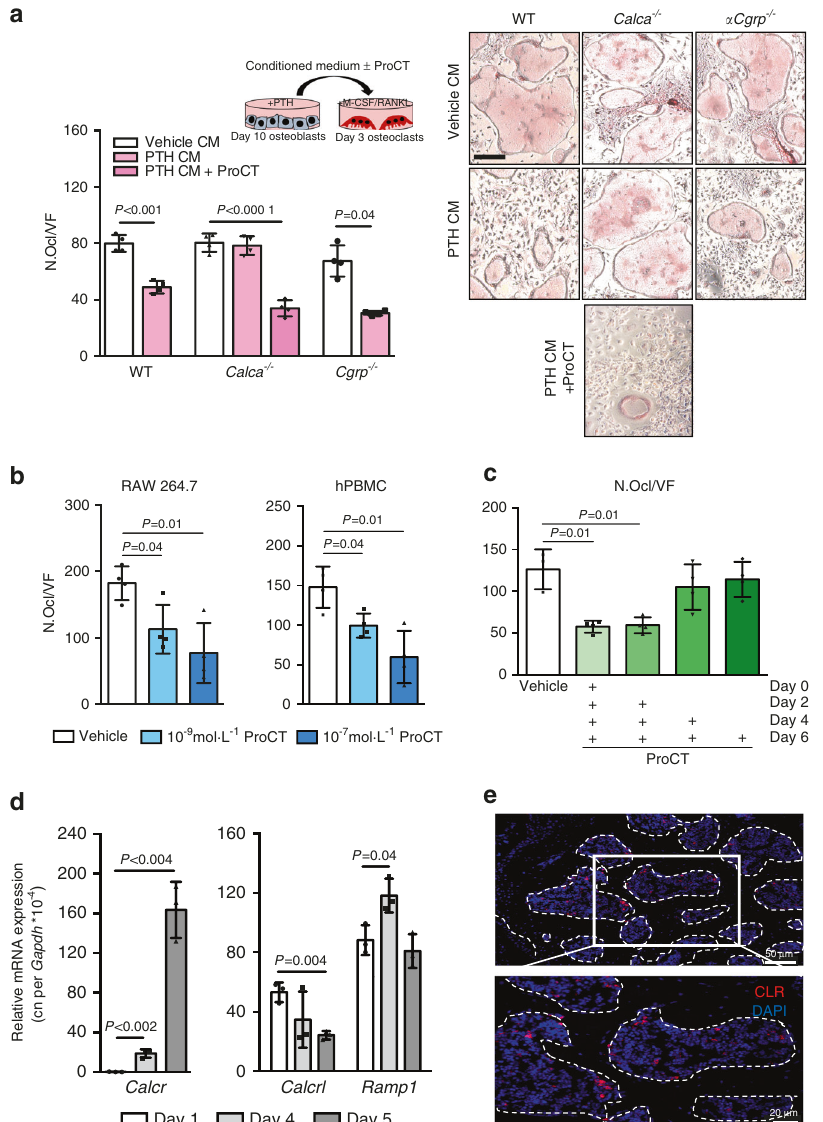
Fig. 6 Osteoblast-derived ProCT inhibits early osteoclastogenesis. a Representative TRAP staining images of WT osteoclasts on Day 4 of differentiation, after treatment with osteoblast conditioned medium (CM) supplemented with M-CSF, RANKL and/or ProCT (200 ng·mL − 1 ) for 24 h (scale bar = 100 μ m). CM was collected from calvarial osteoblasts (Day 10 of differentiation) derived from mice of the indicated genotypes and stimulated with iPTH for 24 h. The quanti fi cation of osteoclast number per fi eld of view is shown on the left (N.Ocl). n = 4 independent cultures per group. b Quanti fi cation of N.Ocl in the murine monocytic cell line RAW 264.7 or human peripheral blood mononuclear cells (hPBMCs) on Day 5 of osteoclast differentiation. n = 4 independent cultures per group. c Quanti fi cation of the number of TRAP-positive, multinucleated cells (N.Ocl) in murine bone marrow-derived osteoclast cultures continuously stimulated with ProCT (200 ng·mL − 1 ) beginning on the indicated days of differentiation. n = 3-4 independent cultures per group. d Gene expression levels (virtual copy numbers) of the osteoclast marker Calcr as a control (left) and the indicated CGRP receptor components ( Calcrl and Ramp1 ) in murine bone marrow-derived osteoclasts during the course of differentiation. n = 3 independent cultures per group. In ( a – d ), one-way ANOVA followed by Tukey ’ s post hoc test was applied. e Immuno fl uorescence staining using a CLR-speci fi c antibody in trabecular bone (spine sections) of untreated WT